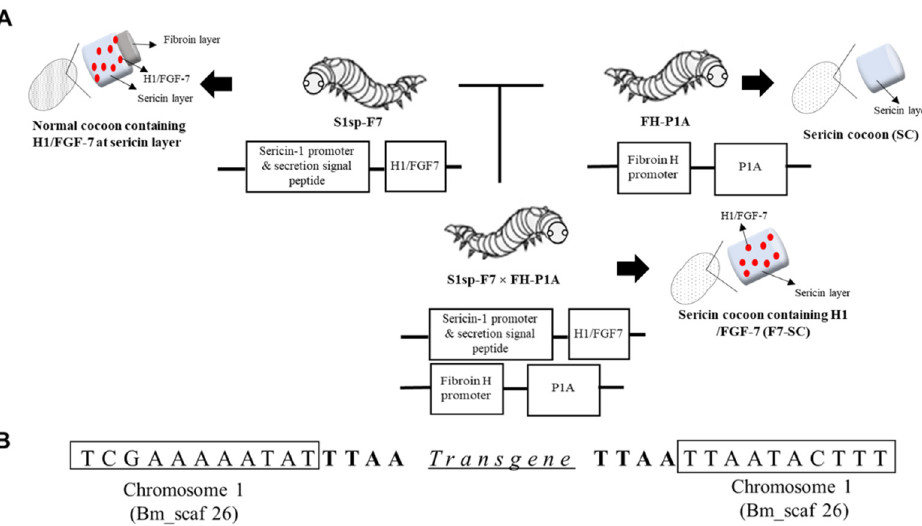
Figure 1. Generation of transgenic silkworm lines. ( A ) Transgenic silkworm lines and the corre- sponding cocoons. Transgenic line S1sp-F7 producing cocoons containing H1/FGF-7 in the sericin layer was mated with the FH-P1A line producing cocoons solely containing sericin (SC) to generate the S1sp-F7 × FH-P1A line. The resultant line, S1sp-F7 × FH-P1A, produced sericin cocoons incor- porating H1/FGF-7 (F7-SC). ( B ) Sequences from chromosome 1 flanking the inserted transgene in line S1sp-F7.